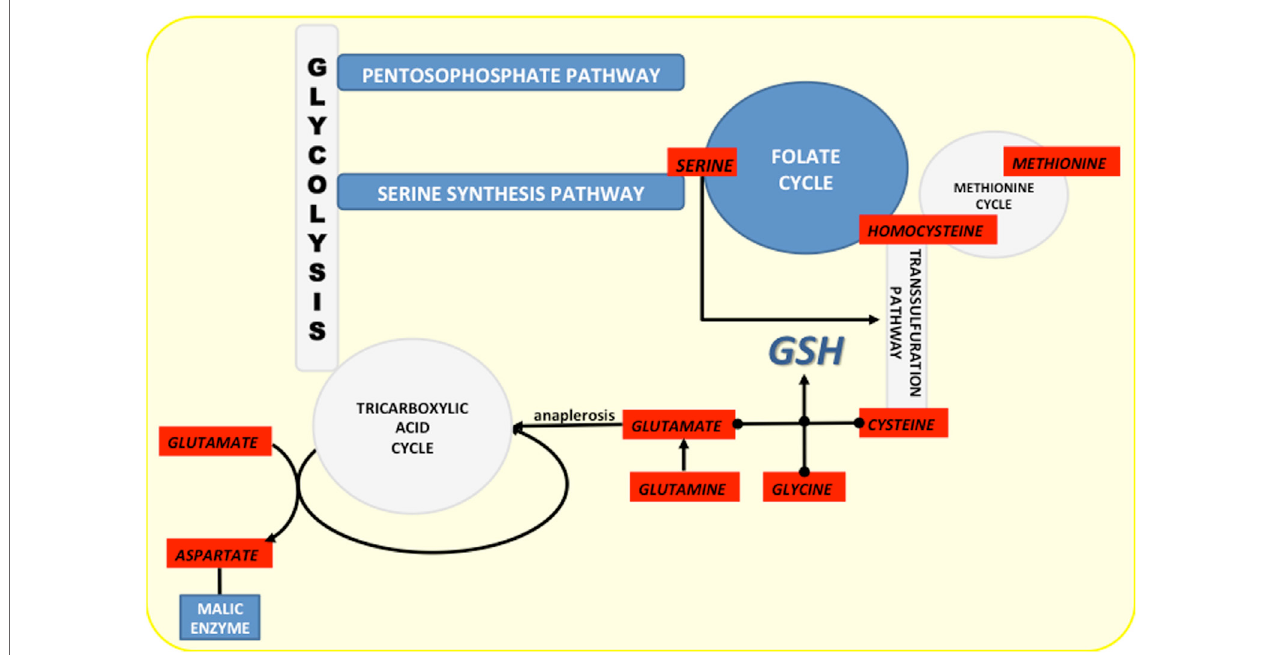
FiGURe 4 | Crossroads of NADPH-producing pathways (marked dark blue) and the pathways from which they diverge or to which they converge (marked light blue). Amino acids involved in these pathways are marked in